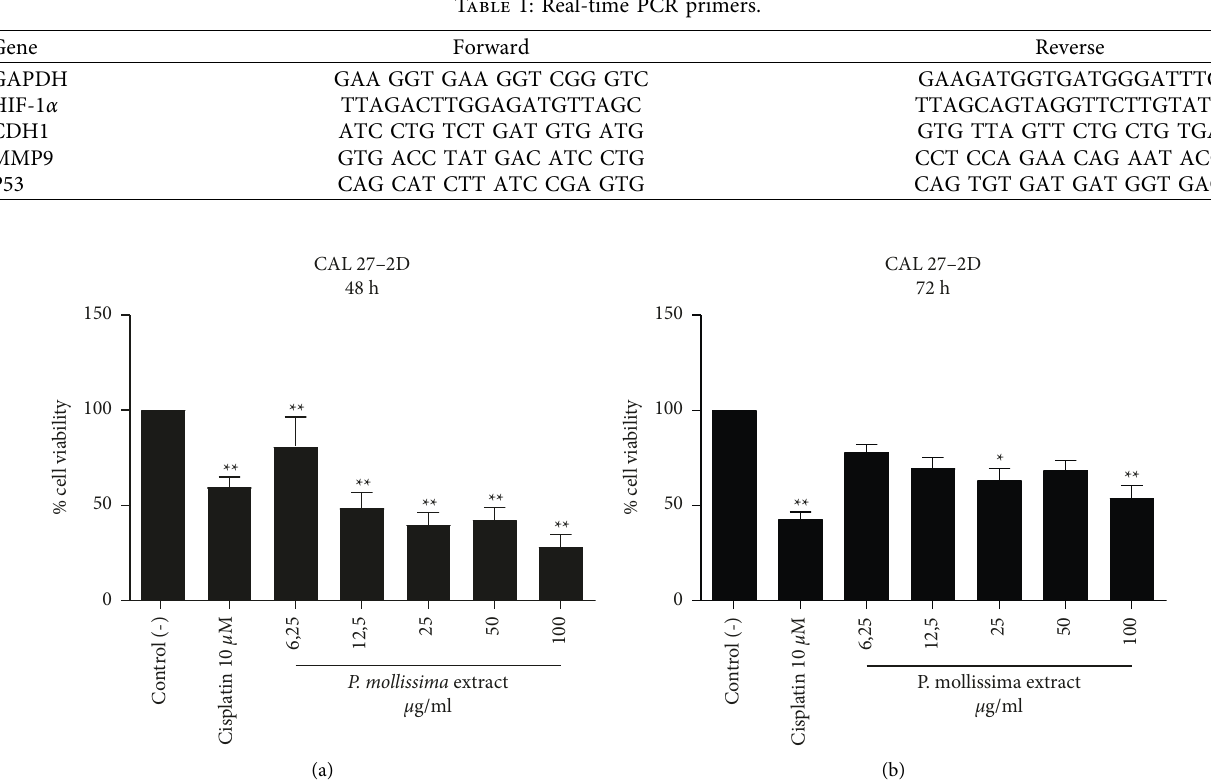
Figure 1: Dose-response effects curve on cell viability of CAL 27cells treated with PME. The cells were treated with five concentrations of the extract (6.25, 12.5, 25, 50, 100 μ g/ml) and 10 μ M cisplatin. Results were compared with control (-) ( ∗∗ p < 0.005). Each bar represents the median and interquartile range of 7 independent experiments ( n � 21) for 48 h and 72h